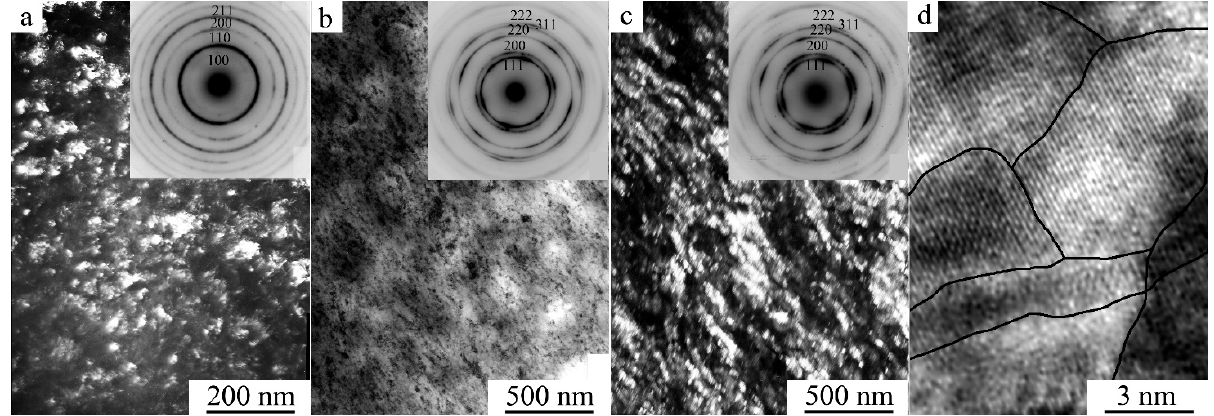
Figure 4. ( a , c ) Dark- and ( b ) bright-field TEM images of the nanostructure, and ( d ) a direct resolu- tion image of the atomic structure of the Ni 50 Mn 28.5 Ga 21.5 alloy subjected to HPT at five revolutions at ( a ) 3 GPa and ( b – d ) 5 GPa, and corresponding SAED patterns (in the inserts). The observations were performed ( a , b , d ) at RT and ( c , insert in Figure 4a) at 120 K.